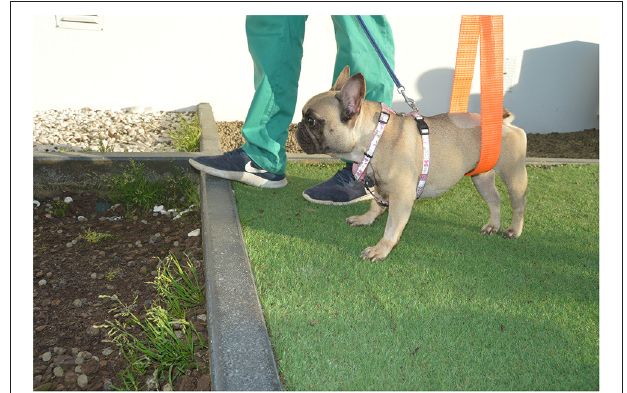
FIGURE 7 | Conventional over ground intervention. Gait Stimulation in different floors surfaces, such as sand, stones, and grass.